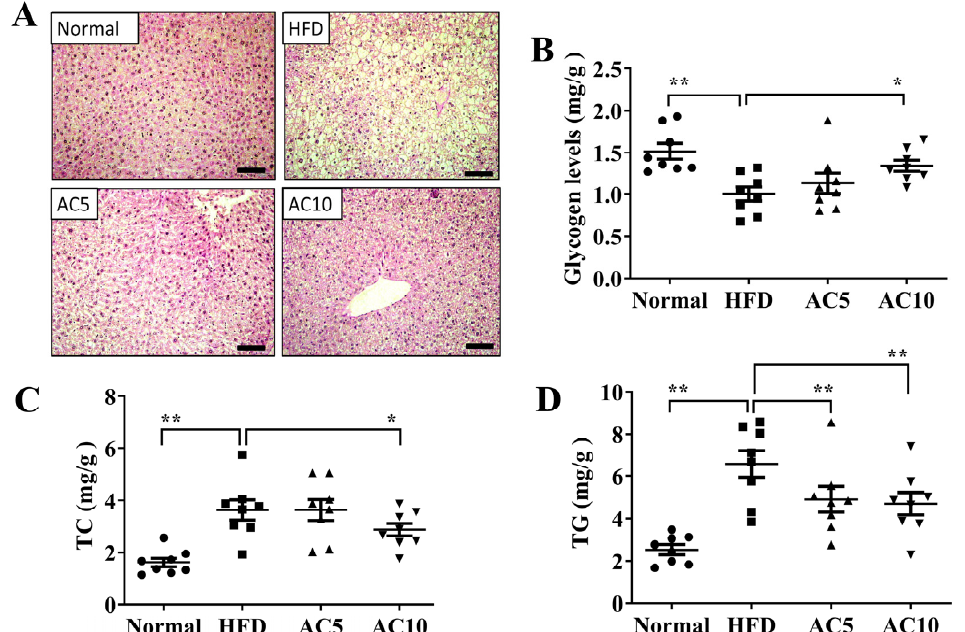
Figure 3. Effect of acacetin (AC) on histopathology of NAFLD in mice. ( A ) PAS staining revealed glycogen distribution in liver (200 × magnification). Quantification of ( B ) glycogen, ( C ) TC, and ( D ) TG levels in liver tissue. Values are presented as mean ± SEM. * p < 0.05, ** p < 0.01 compared to obese mice. (scale bar = 100 µm).